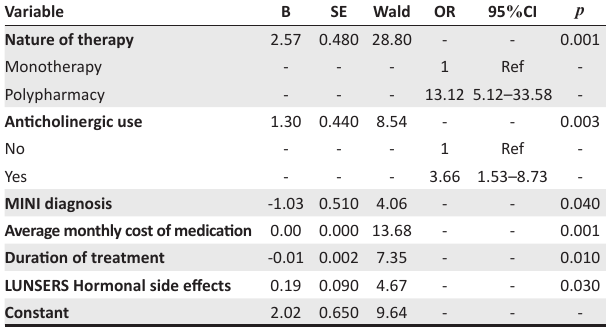
TABLE 6: Independent predictors of ‘high dose’